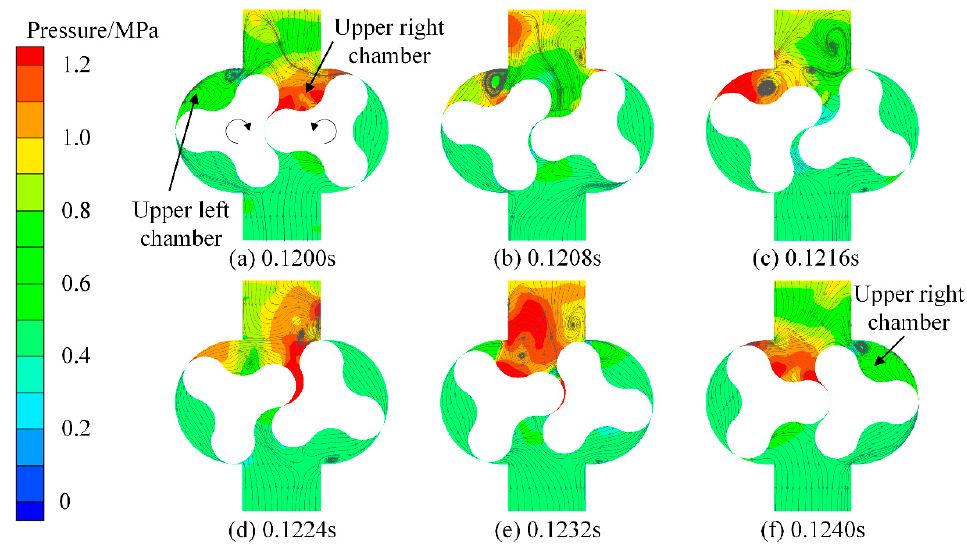
Figure 6. Pressure streamline contours of the Roots pump when the inlet CO 2 volume fraction is 0.8. Flow time: ( a ) 0.1200 s; ( b ) 0.1208 s; ( c ) 0.1216 s; ( d ) 0.1224 s; ( e ) 0.1232 s; ( f ) 0.1240 s.